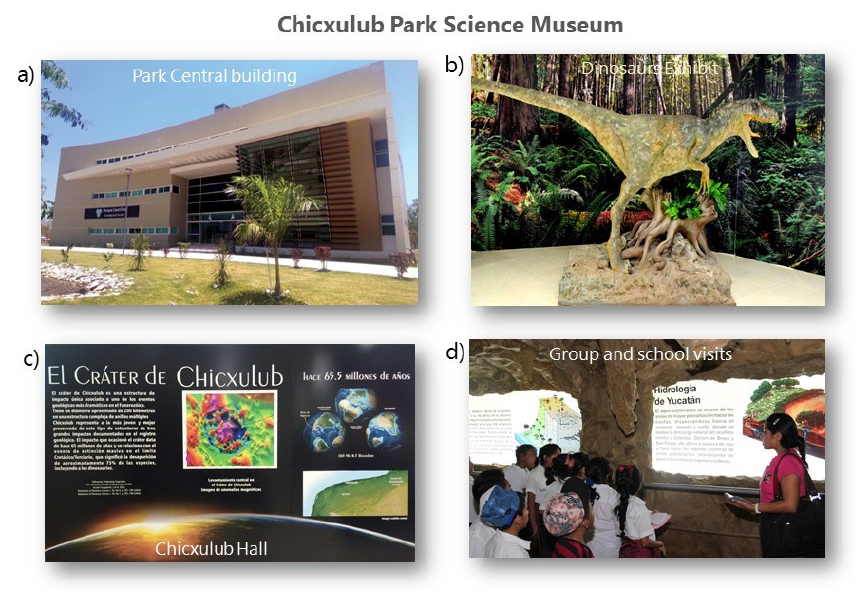
Figure 5. Chicxulub science museum in the PCYTY Yucatán Science Park. The central library building houses the museum in the second and third floors. Views of the exhibits are also shown (see also Perez-Cruz and Urrutia-Fucugauchi, 2015).